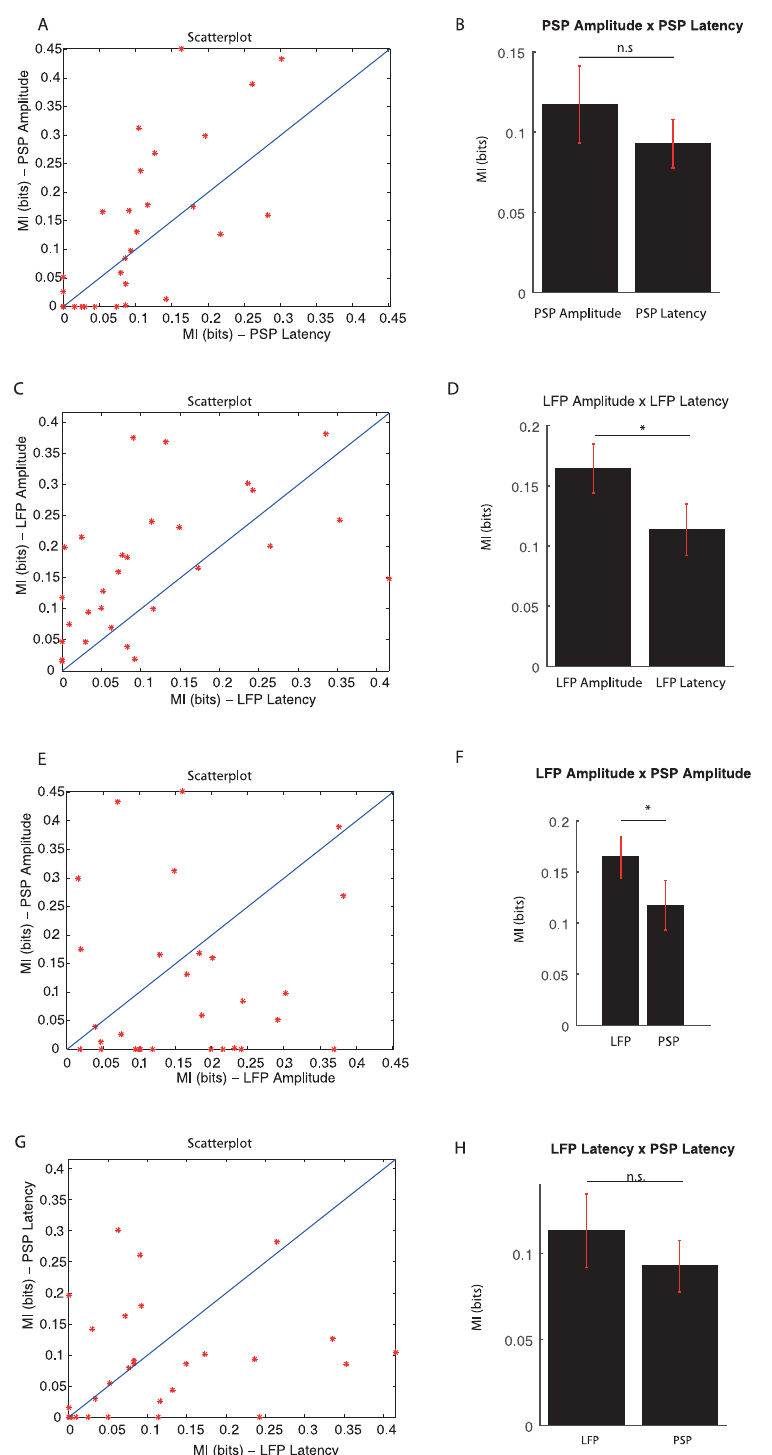
Fig 5. MI estimates from PSP latencies, PSP amplitudes, LFP latencies and LFP amplitudes, in bits. (A, C, E, G) Scatterplots for PSP amplitude MI versus PSP latency MI, LFP amplitude MI versus LFP